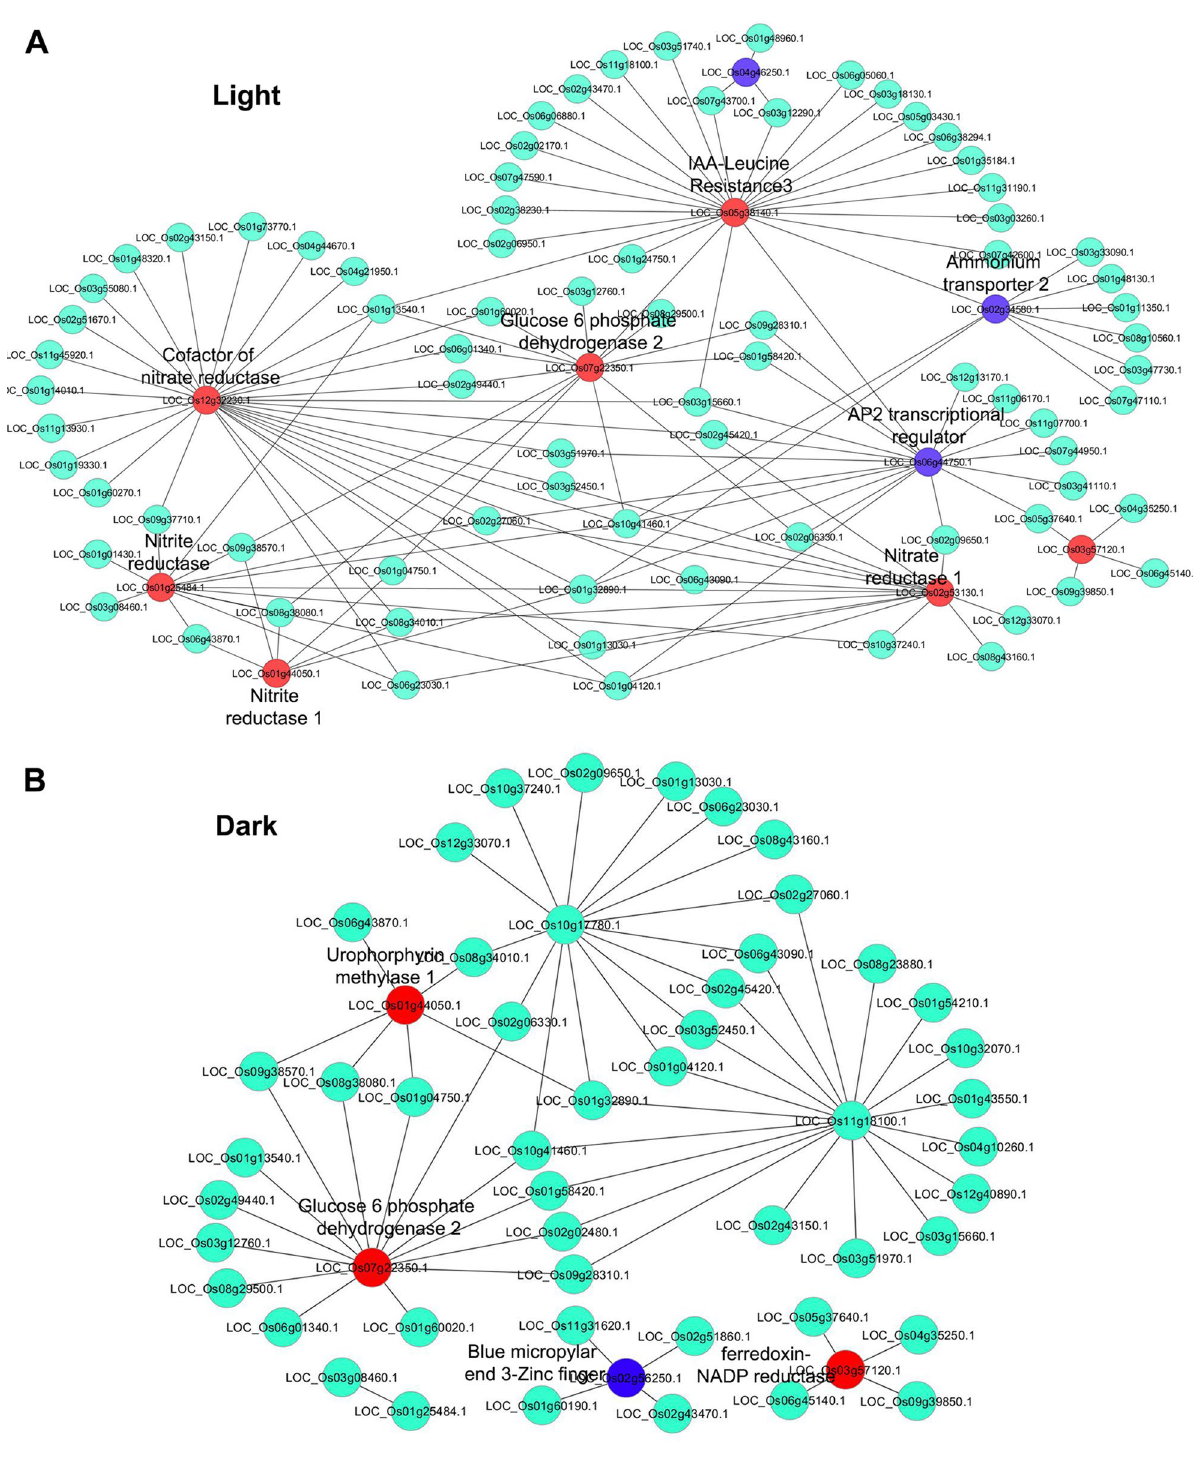
Figure 8. Transcriptional regulatory network of nitrate-responsive genes in light and dark. Nitrate-responsive transcriptional regulatory networks (NTR) in light ( A ) and dark ( B ) were generated using known information in Arabidopsis. NTR networks were constructed in Cytoscape version 3.0.0 (https ://cytos cape.org/) 67 using rice orthologs and the expressions of DEGs were mapped onto the networks. The red and purple nodes represent the up- and down-regulated DEGs and light colour nodes are interactors but not